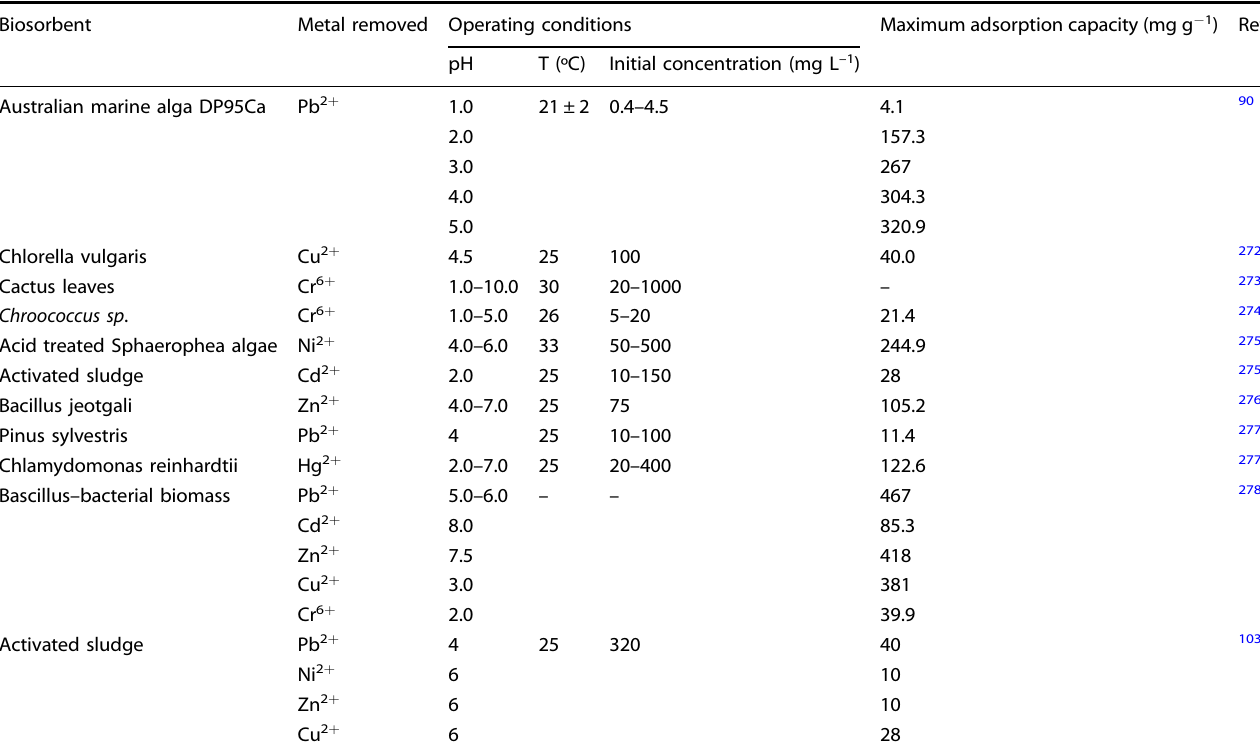
Table 3. Biosorption of heavy metals by several biosorbents.